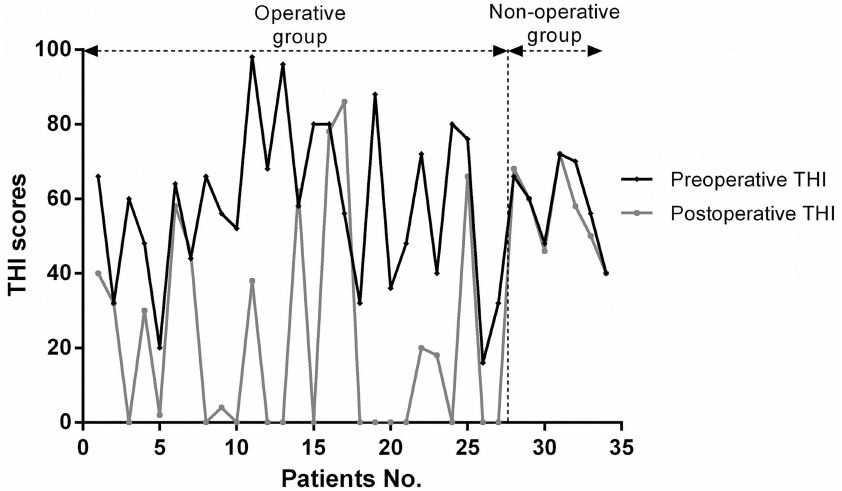
Fig 2. Tinnitus Handicap Inventory (THI) scores. The black and grey spots denote the preoperativeand follow-upTHI scores, respectively. The vertical dotted line separates the surgery (Patients 1–27) and non- surgery (Patients 28–34)